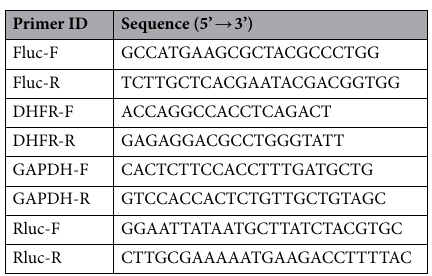
Table 2. List of oligonucleotides used in qRT-PCR assays.